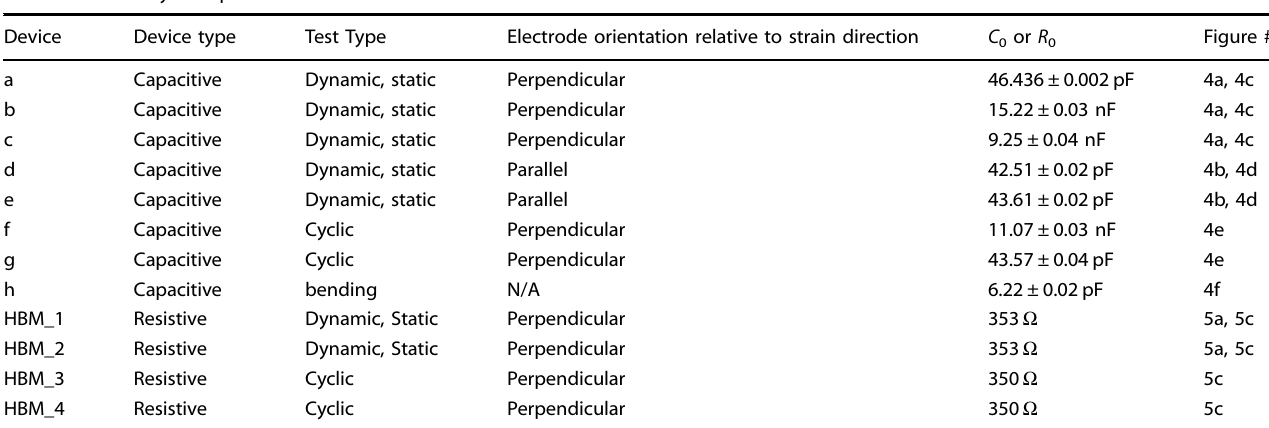
Fig. 3 Device design parameters for printed CSG interdigitated electrode structure. a Schematic detailing the variables to calculate theoretical capacitance, and the b values associated with these variables, where dimension values are reported as an average with standard deviations of measurements representative of the entire device. Table 1. Summary of